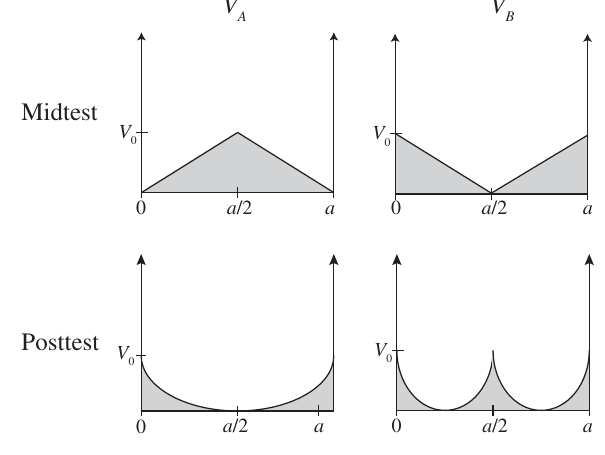
FIG. 4. The mid- and post-test questions using two perturbed infinite wells of width a . Students were given the graphs shown and asked the questions below the graphs, with a prompt to explain their reasoning for each question.